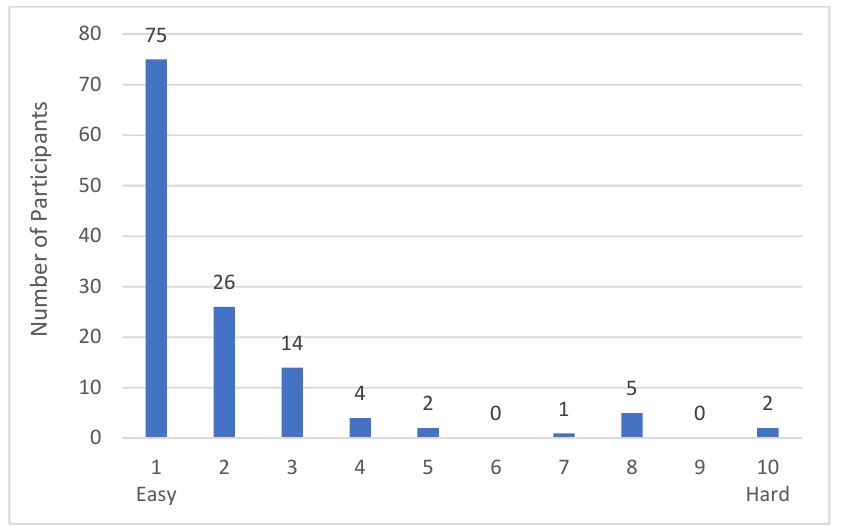
Figure 3. Participants’ difficulty rating of the Oxford Meat Frequency Questionnaire. Responses from study participants to the evaluation question “How easy or hard did you find filling in the questionnaire? (Scale from 1 easy to 10 hard)”, collected on the last day of the study (Day 7, Week 3). n = 129.